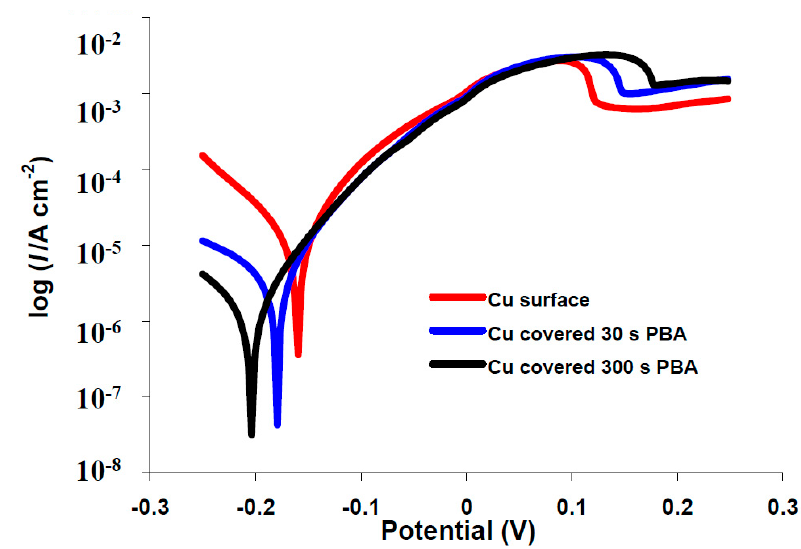
Figure 5. Typical polarization curves for corrosion in 3.5% NaCl of copper electrode ( ─ ), covered with 4-phenylbutyric acid (PBA): 30 s ( ─ ) and 300 s ( ─ ).